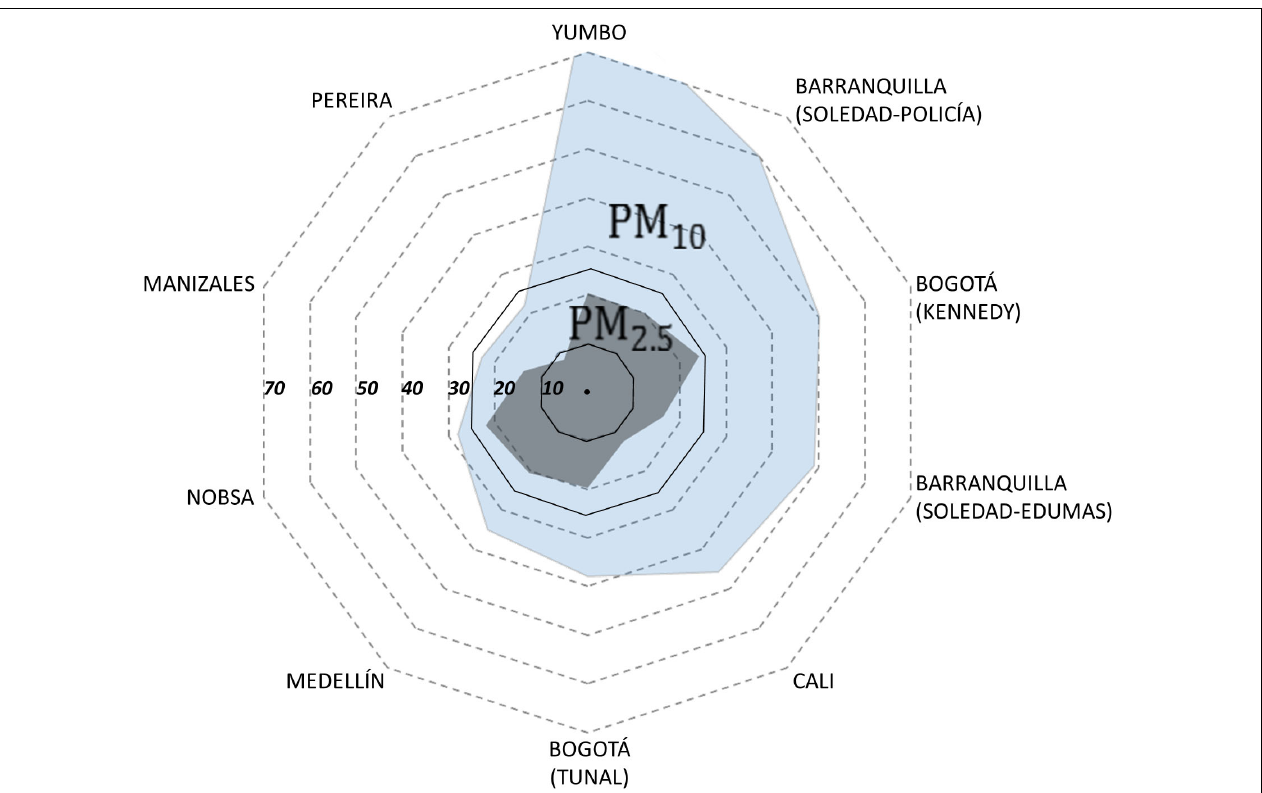
FIGURE 1 | 2018 average concentrations (in µ g/m 3 ) of particulate matter for several Colombian